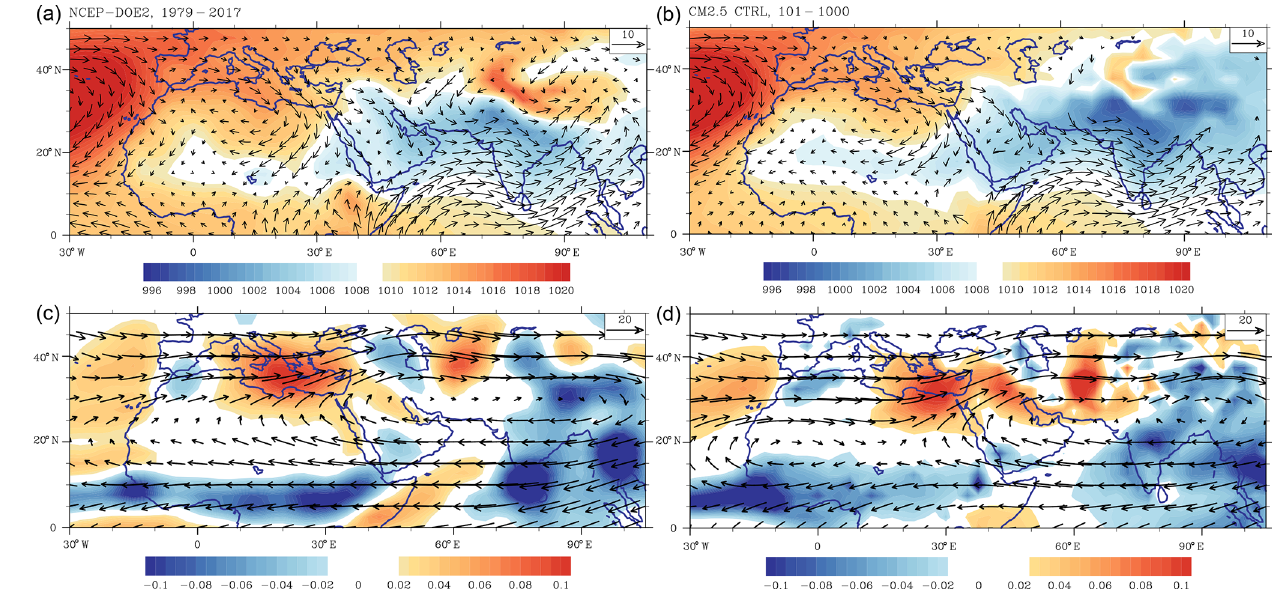
Figure 1. Seasonal (JJA) time-mean sea level pressure (hPa) and wind vector at 850hPa (ms − 1 ) in (a) NCEP-DOE2 and (b) CM2.5. Seasonal (July) time-mean vertical velocities at 500hPa (Pas − 1 ; downward motion denoted with positive values) and wind vectors at 200hPa (Pas − 1 ; downward motion denoted with positive values) estimated for (c) NCEP-DOE2 and (d) CM2.5 CTRL. Observational data are used for 1979– 2017, and control simulation data are used for years 101–1000. All datasets are interpolated to the 2.5 ◦ horizontal grid.